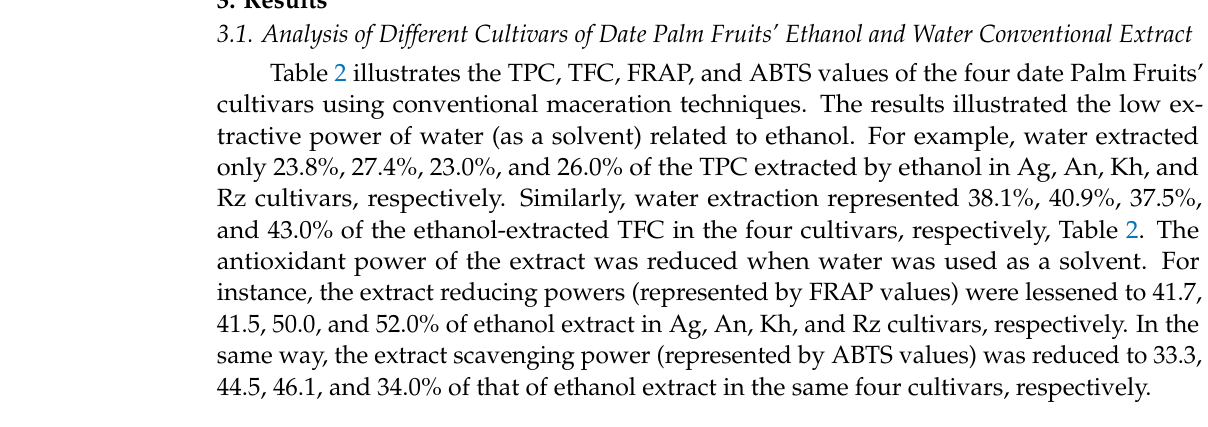
Table 2. Conventional ethanol and water extraction results for the date palm fruit cultivars under investigation; Agwa, Anbarah, Khlas, and Reziz. The four different responses were analyzed; total phenolic content (TPC), total flavonoid content (TFC), Ferric Reducing Antioxidant Power assay (FRAP), and ABTS scavenging effect